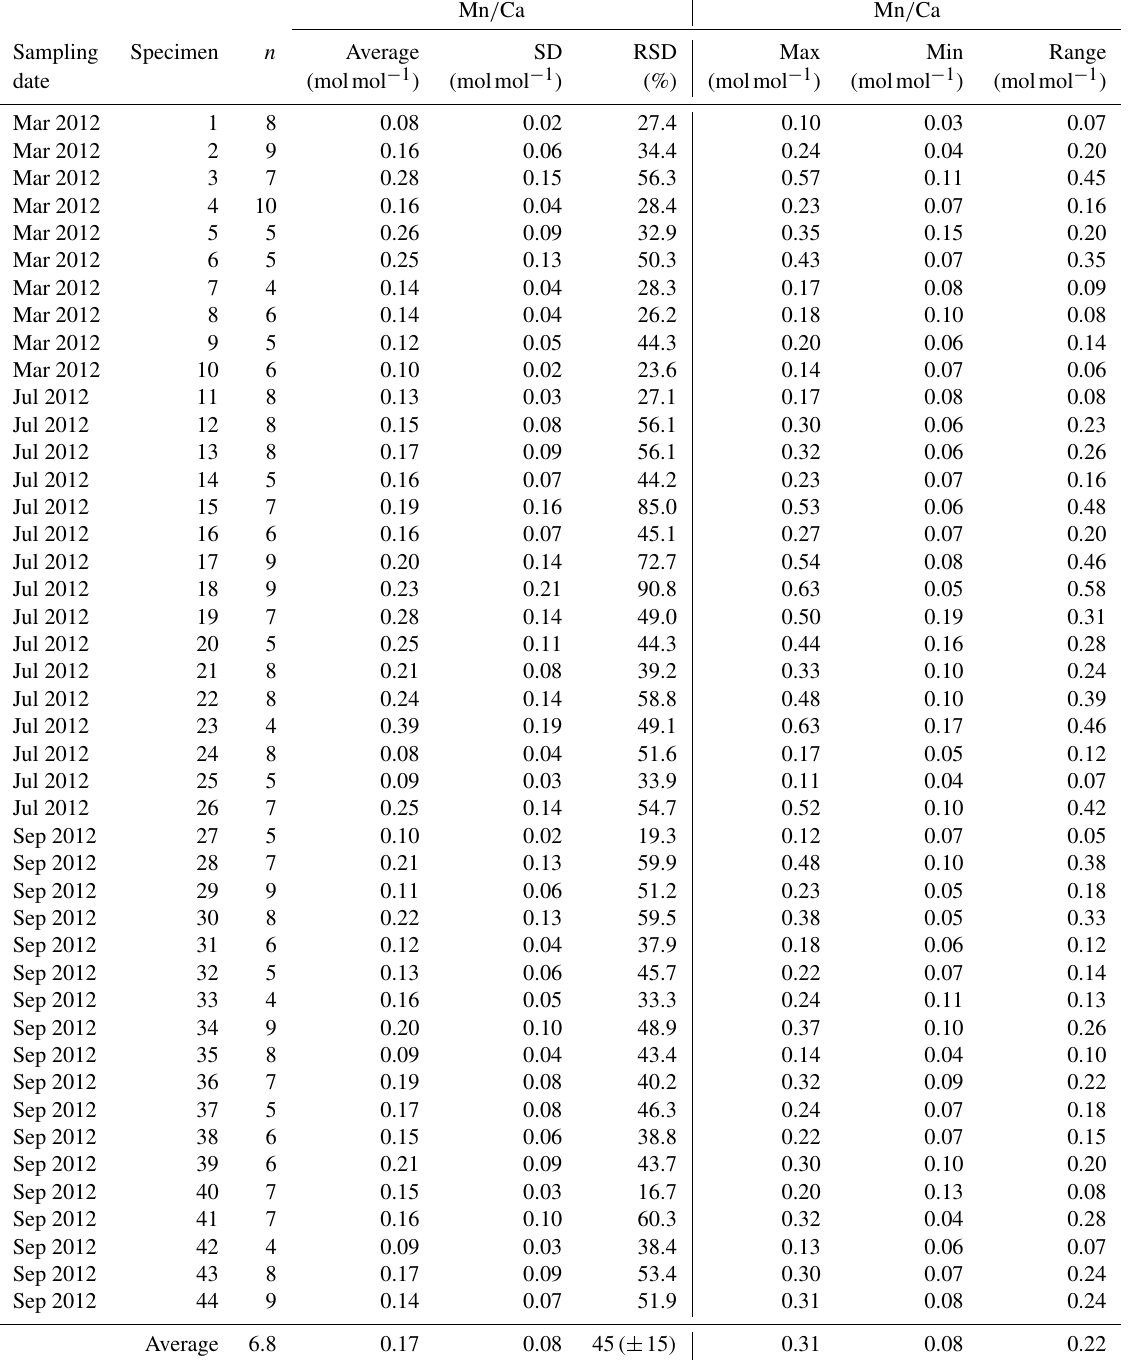
Table A1. Results of Mn / Ca measurements for different samplings of living specimens of A. tepida from Lake Grevelingen, station ST2. All data are normalized to NIST SRM 612. Values are calculated per specimen (numbers of specimens according to Fig. 2). The total number of chambers included is indicated in column “ n ”. Calculations were performed using all